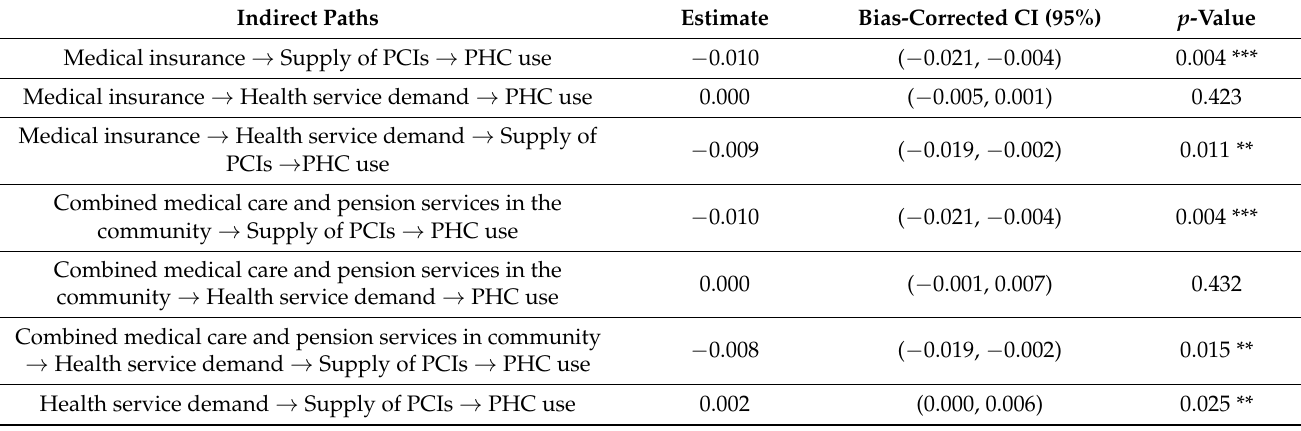
Figure 2. Structural equation model (Note: * p < 0.1; ** p < 0.05; *** p < 0.01). Table 4. Indirect path load factors.